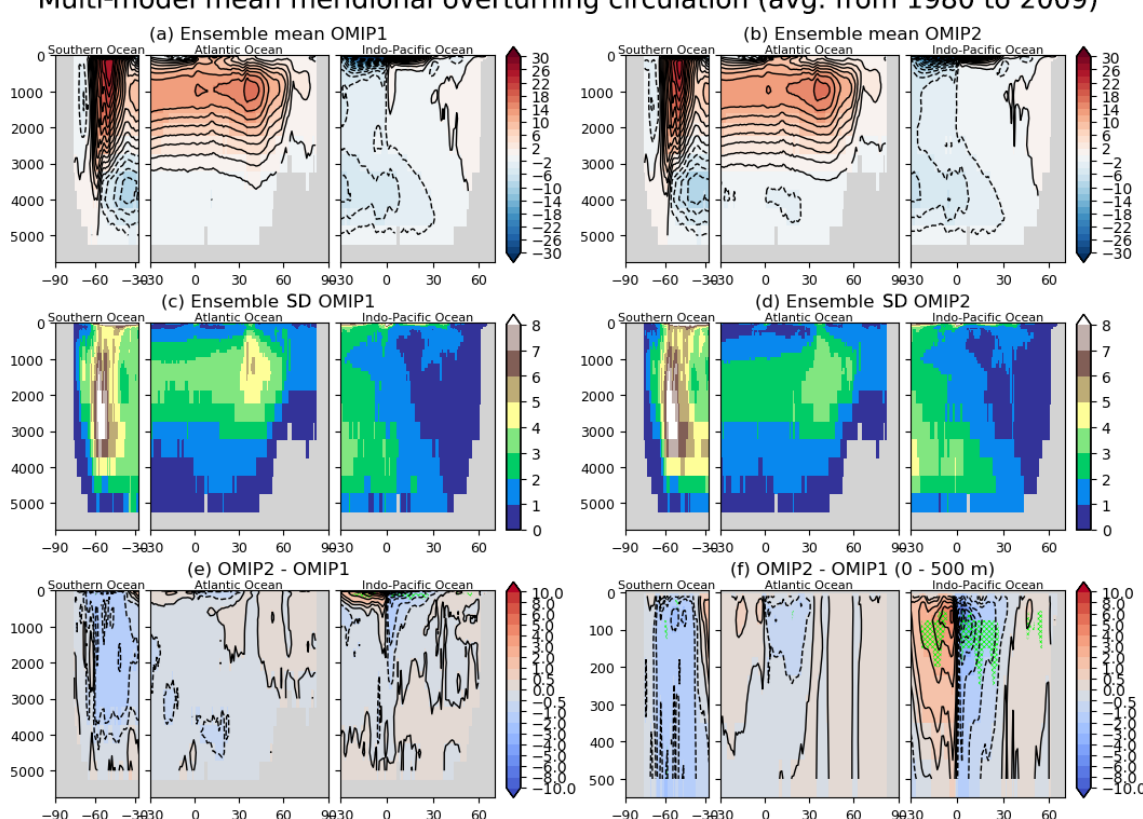
Figure 15. Panels (a) and (b) show multi-model mean, 30-year (1980–2009) mean meridional overturning stream function in three oceanic basins. Clockwise circulations are implied around the positive extremes, and vice versa. (a) OMIP-1 and (b) OMIP-2. Panels (c) and (d) show the standard deviation of the ensemble. (c) OMIP-1 and (d) OMIP-2. (e) Difference between OMIP-2 and OMIP-1 (OMIP-2 minus OMIP-1). Panel (f) is the same as (e) but for the upper 500m depth. Units are 10 9 kgs − 1 . In panels (e) and (f) , the regions where the difference is significant at 95% confidence level are hatched with green as in Fig. 6. See Figs. S39–S41 for results of individual